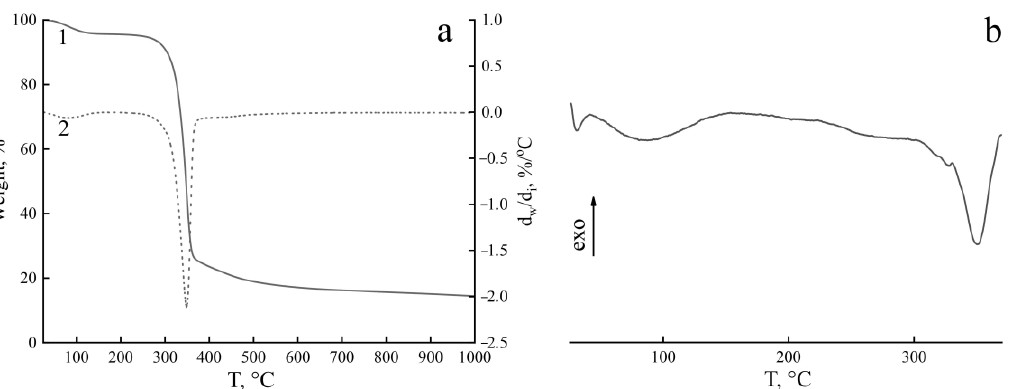
Figure 13. TGA ( a, 1 ), DTG ( a, 2 ) and DSC ( b ) data of fibers spun from 7% solutions of flax noils cellulose in NMMO. Atmosphere: argon 50 cm 3 /min. Linear heating at 10